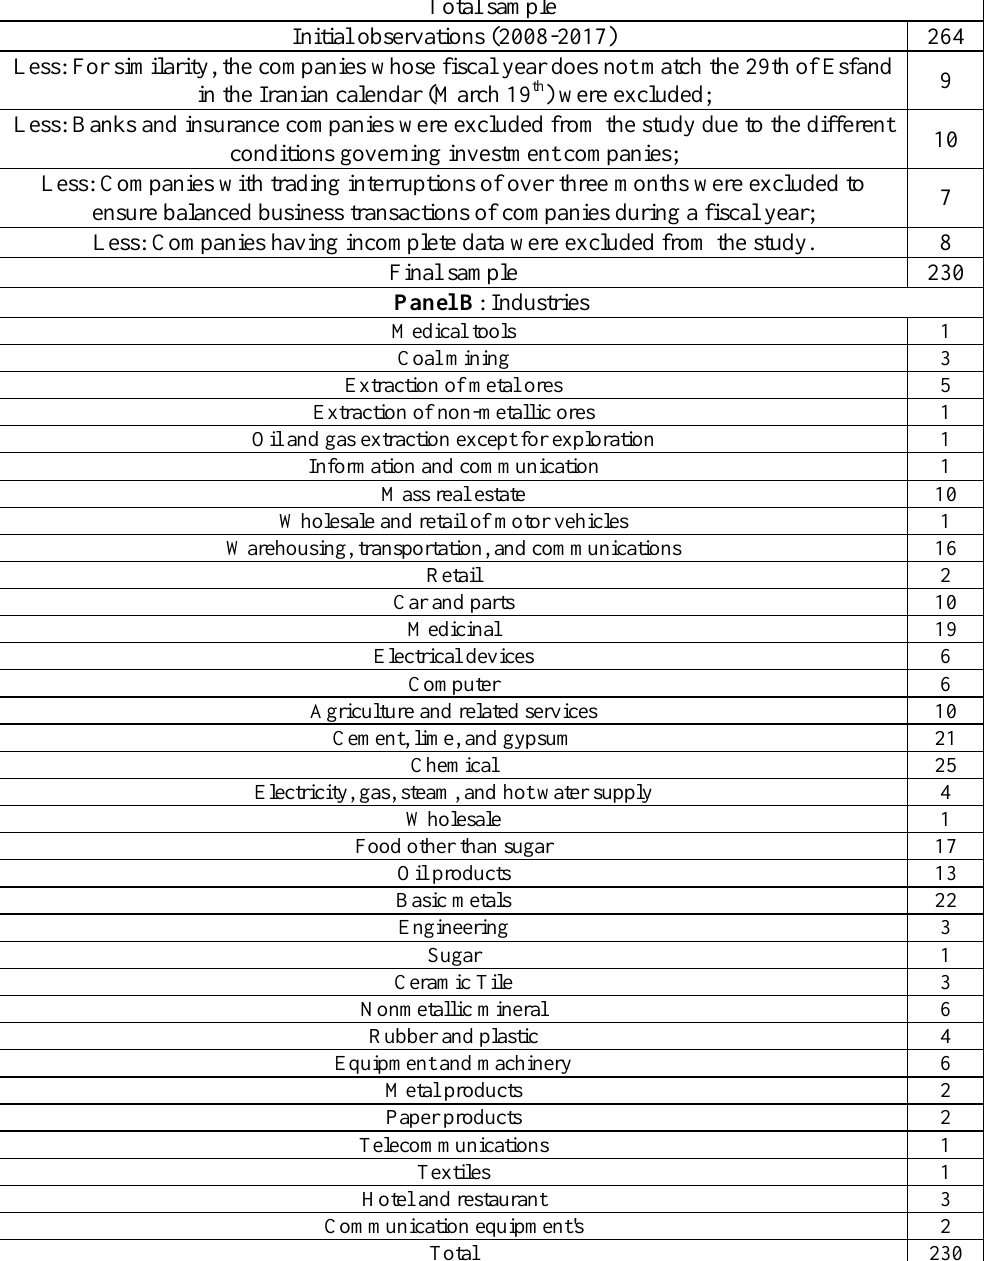
Table 1. Panel A: Sample selection procedure Total